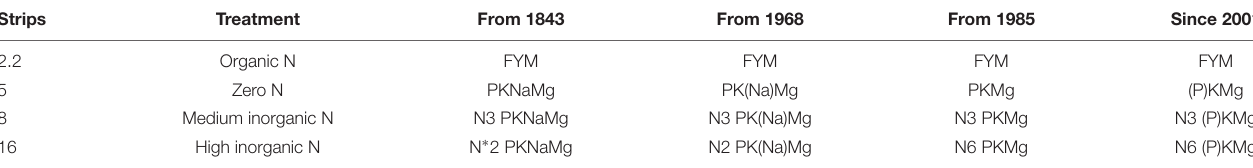
TABLE 1 | Fertilization regime adopted in Broadbalk experiment for the four treatments used in this study.